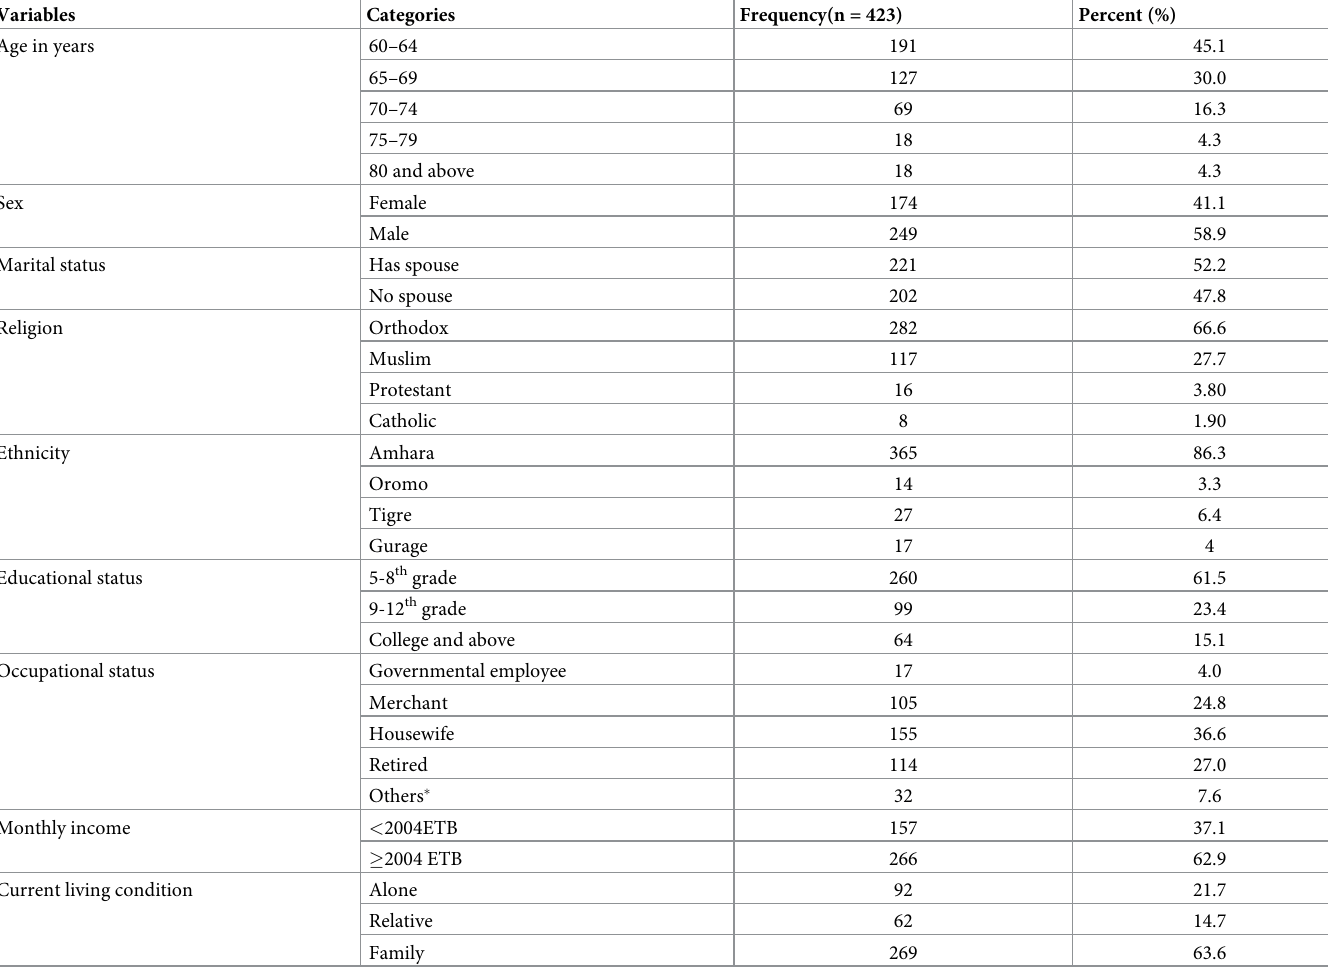
Table 1. Socio-demographic characteristics of older adults in Bahir Dar city administration, northwest, Ethiopia, 2020 (n =